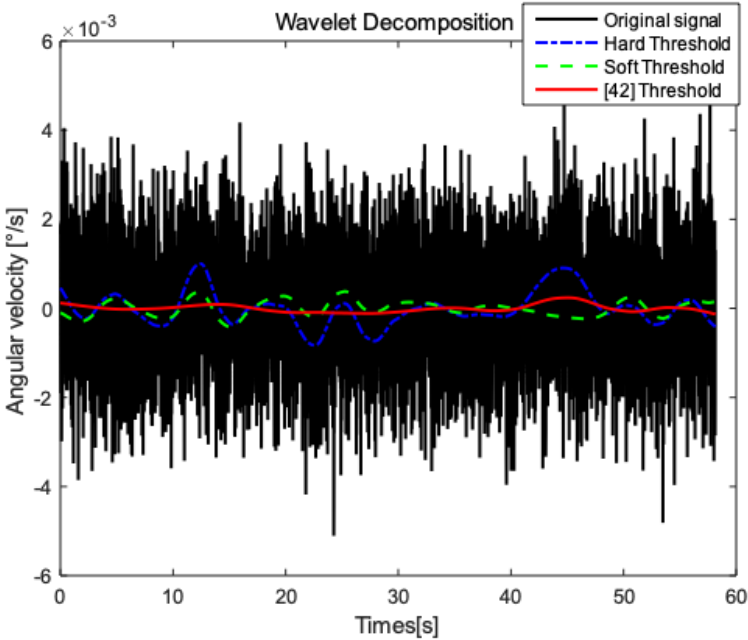
Figure 5. Comparison of original signal and reconstructed signals based on different thresholds.